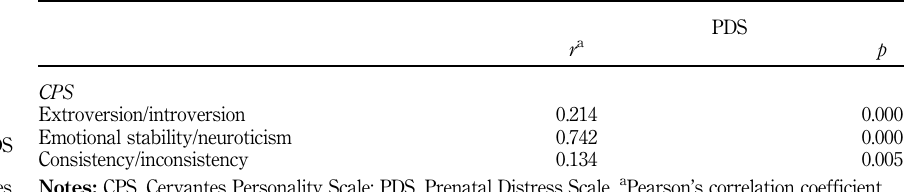
Table VI. The correlations PDS and CPS total and sub-dimension